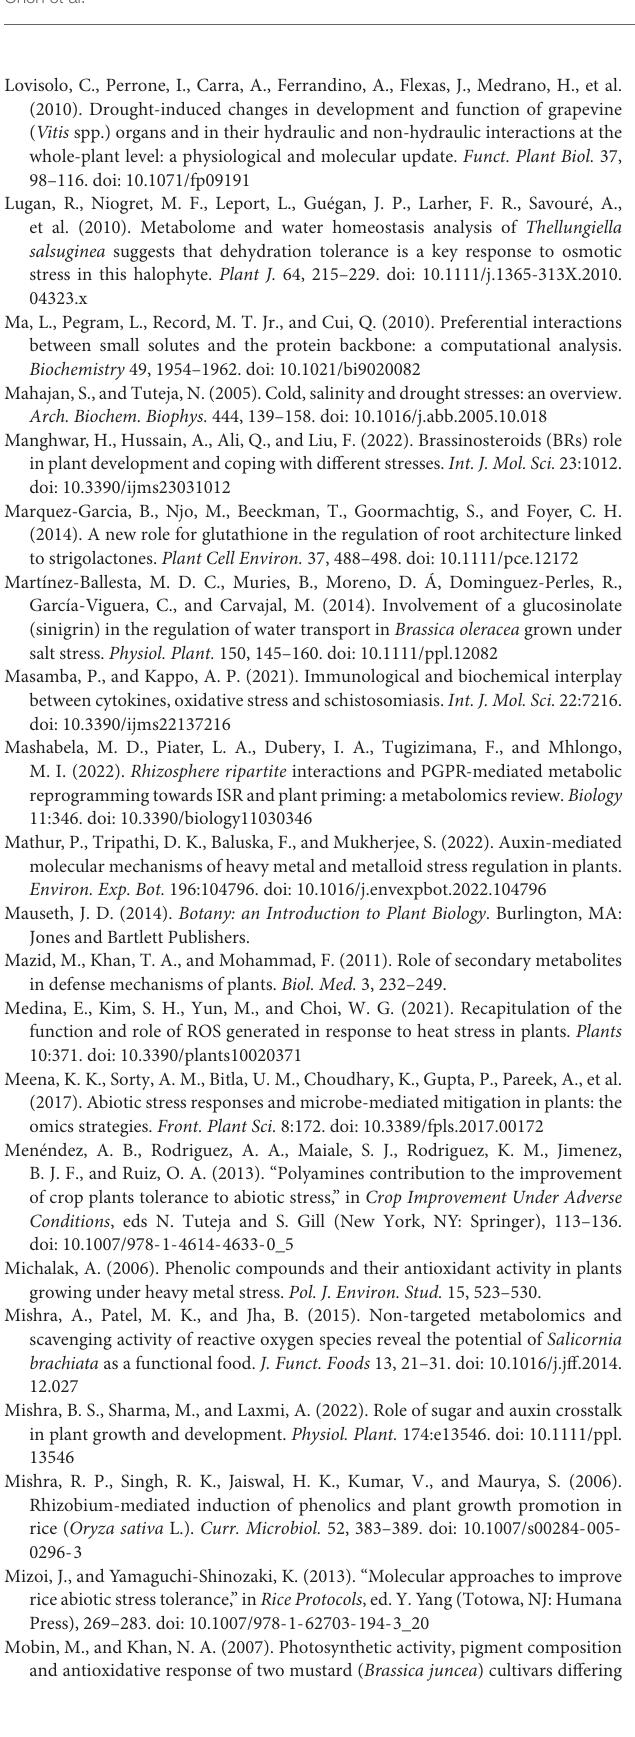
Frontiers in Plant Science |